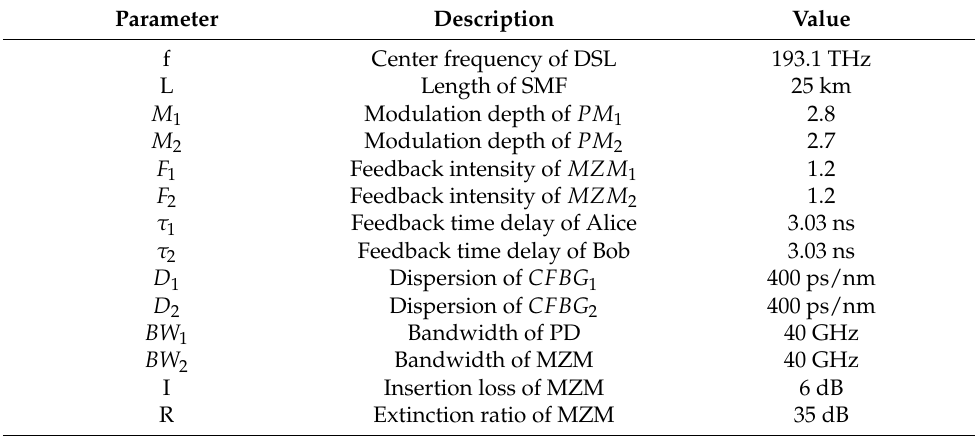
Table 1. Values of parameters used in the simulation system.